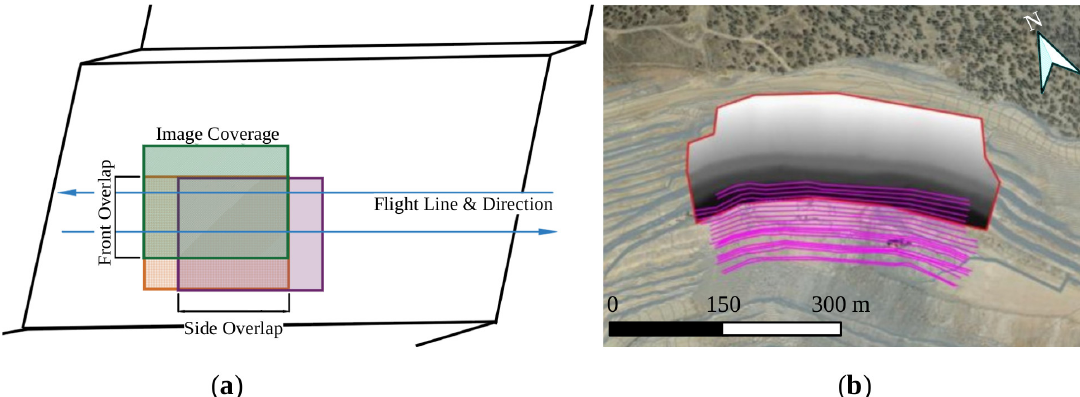
Figure 1. ( a ) Schematic of the overlap and flight path design for pit wall mapping. ( b ) Flight plan design for Mine D; the flight paths are shown in magenta, and the area of interest is outlined in red with the DEM inside the